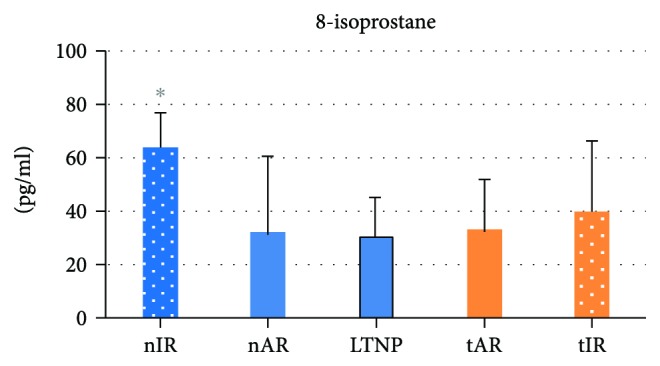
Plasma levels of 8-isoprostane of 92 people living with HIV/AIDS, according to the five composed groups. This marker is upregulated in nIR. Statistical tests: gamma distribution. ∗
p < 0.05, difference among all the other groups.